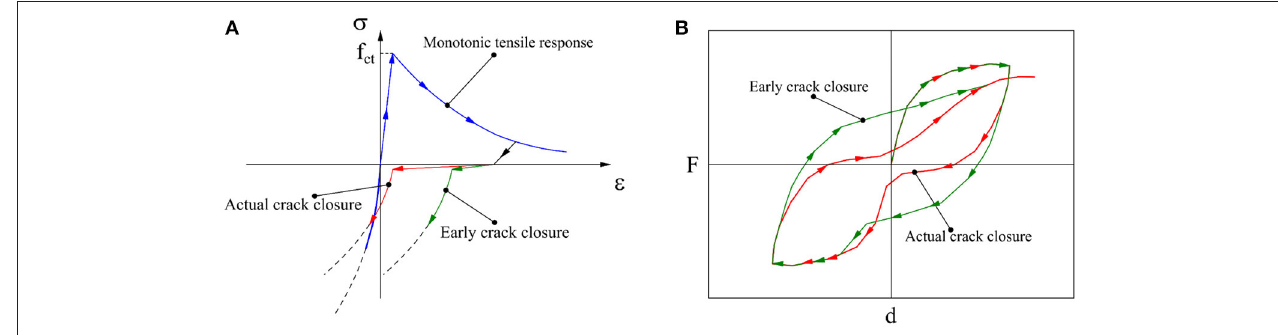
FIGURE 2 | Effect of the cracking closure simulation (A) in the mechanical model and (B) in the global response showing the pinching